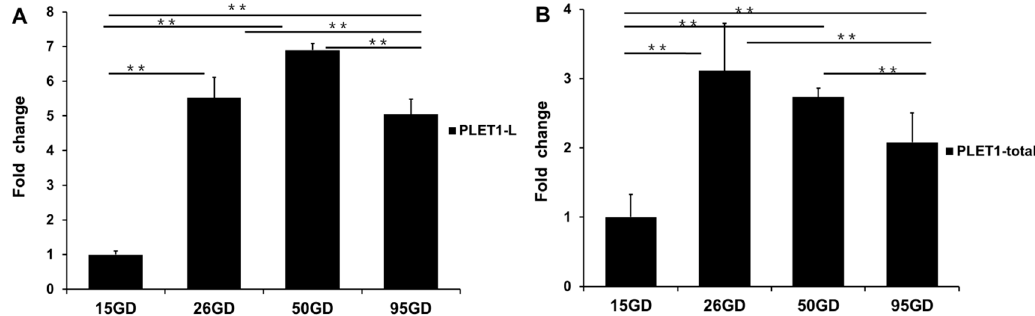
Figure 5. Detection of the PLET1-L and PLET1-total mRNA in conceptuses (Day 15 of gestation) and placentas (Days 26, 50, and 95 of gestation) by qRT-PCR. ( A ) The mRNA profile of PLET1-L ; ( B ) The mRNA profile of PLET1-total . ** p < 0.01. GD: gestational day.